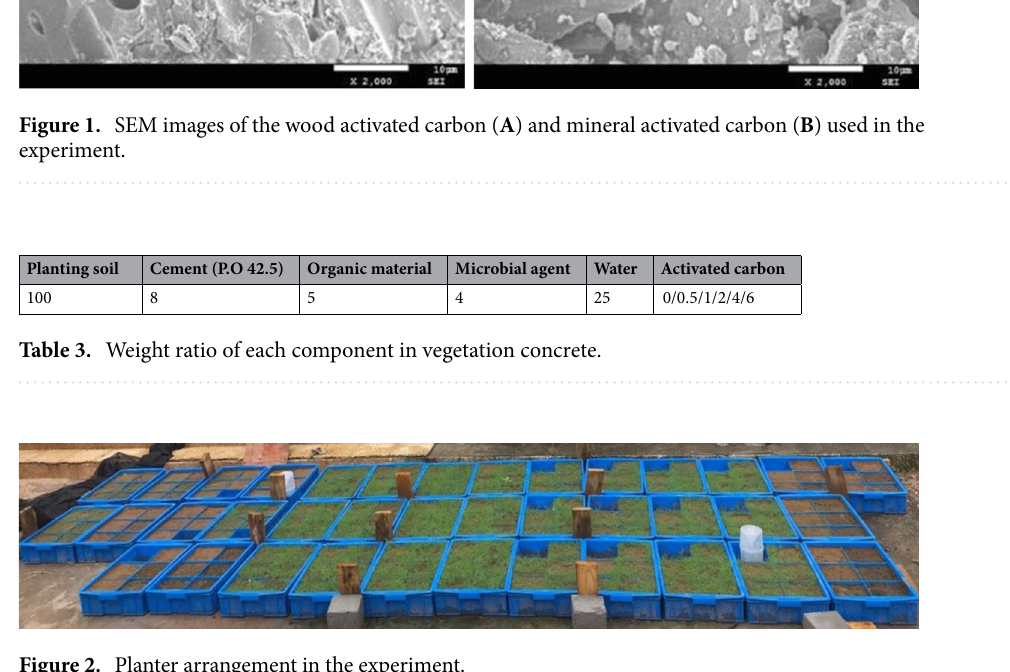
Figure 2. Planter arrangement in the